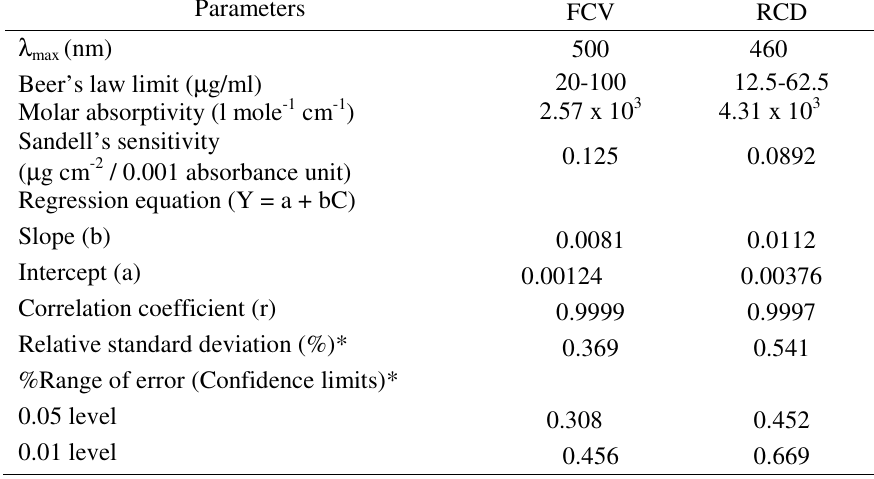
Table 1. Optical characteristics and precision of the proposed methods Parameters